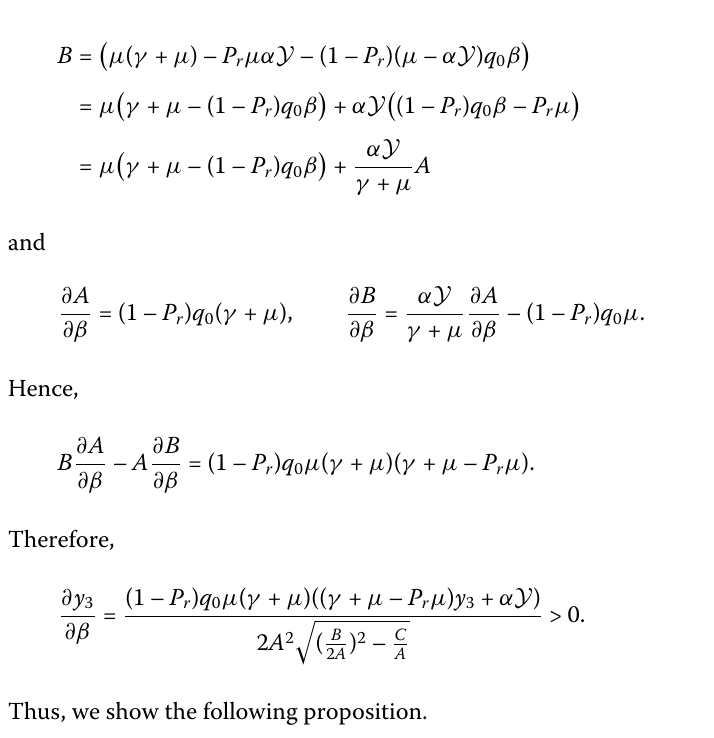
On the other hand, we